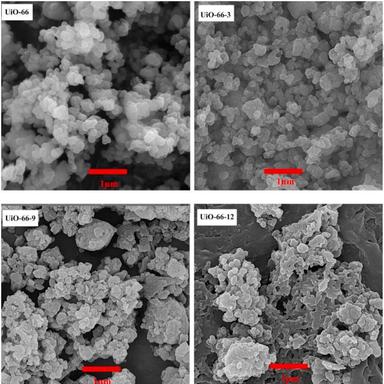
The SEM images of the as-synthesized UiO-66, and Uio-66 after 3, 9, and 12 months of water aging .